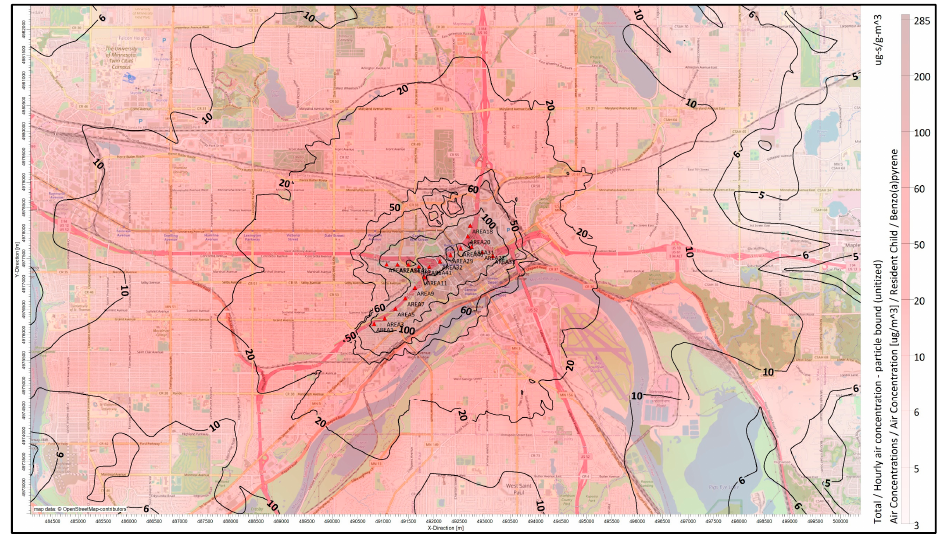
Figure 10. BaP Hourly Air Concentration—Particle-Bound Phase (Unitized) Contour Plot overlaid on OpenStreetMap Satellite Imagery (OpenStreetMap, n.d.). Unit used in contour is µ g-s/g-m 3